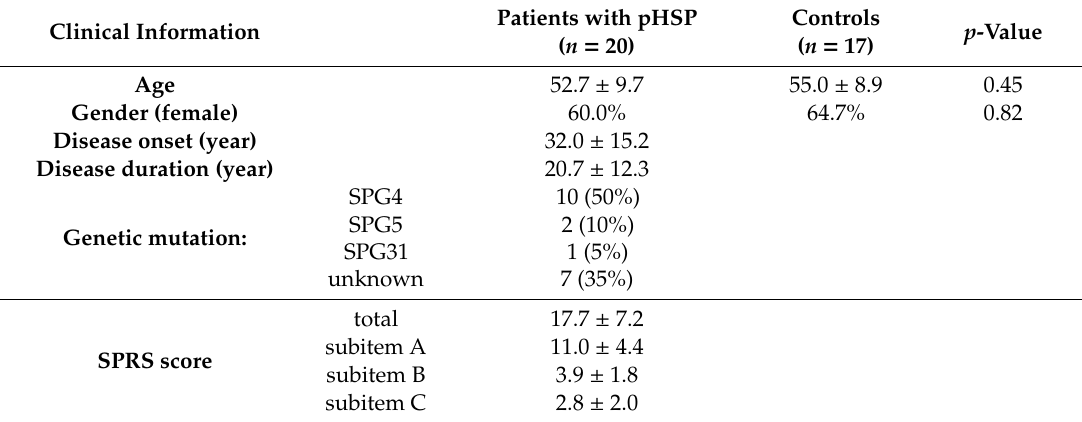
Table 1. Demographic and clinical characteristics of hereditary spastic paraplegia (HSP) patients and control